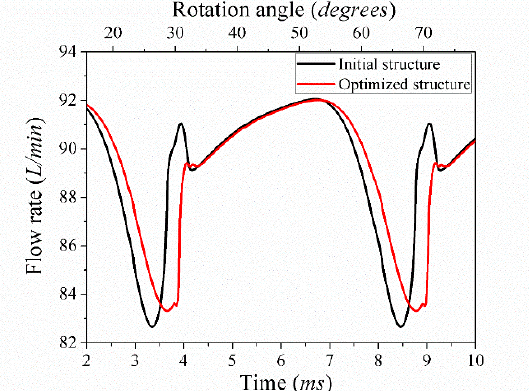
Figure 13. Comparison of initial structure and optimized results.